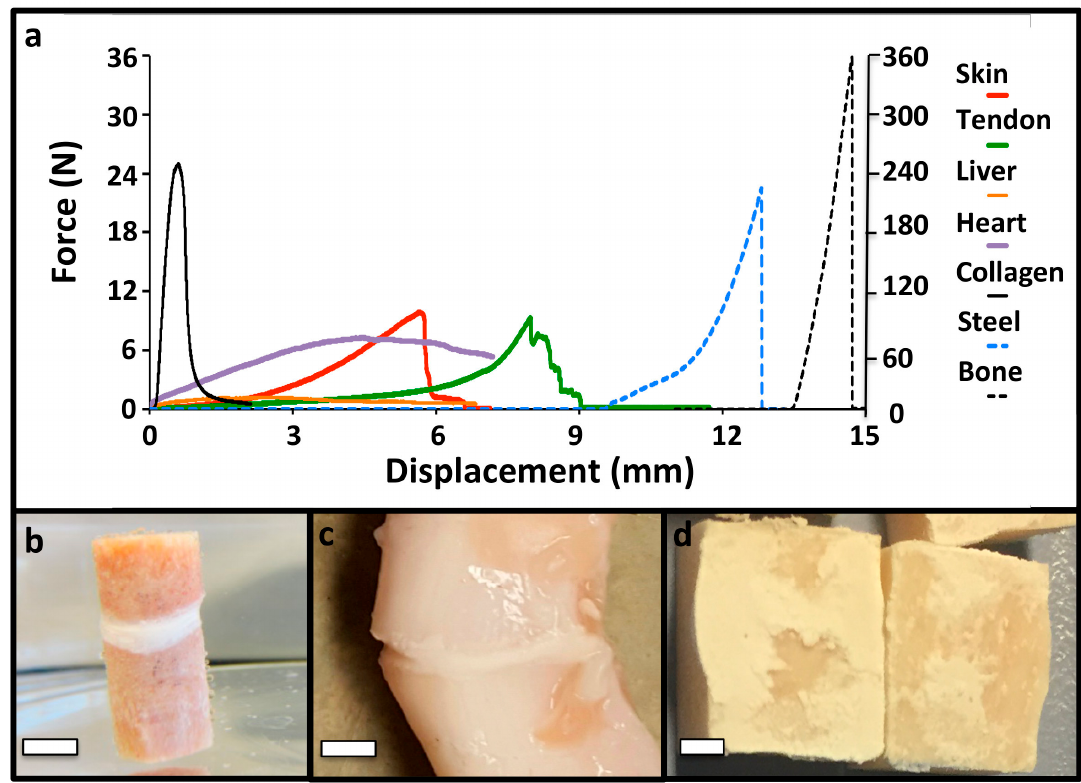
Figure 3. PM-CPC bonds to different tissue types and biomaterials. ( a ) Representative force/ displacement curves of PM-CPC bonded to different tissues and biomaterials (bone/steel use the right y-axis (Force); all other tissues/materials use the left y-axis (Force)). Note that the initial displacement values have been shifted for clarity, while the total displacement remains accurate, for each sample (i.e., steel samples were displaced approximately 3 mm before failure, though in ( a ) the start of displacement has been shifted by 9.5 mm so it no longer overlaps with soft tissue samples). The test surface area was approximately 1 cm 2 . Soft tissues and collagen were tested by lap shear, as described in the Methods section. ( b ) Representative images of articular cartilage; ( c ) tendon; ( d ) or bone after shear testing to failure, glued to the same tissue type (i.e., articular cartilage to articular cartilage). Note the thin, white layer of PM-CPC between the two segments of tendon ( c ). The PM-CPC failure mode was cohesive, mixed failure ( d ). In ( b – d ) 30% PM-CPC was used. Scale bar dimensions are 5 mm, 3 mm, and 2.5 mm for ( b ), ( c ), and ( d ), respectively.